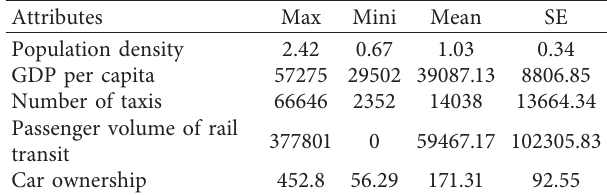
Table 2: Descriptive statistics of exogenous